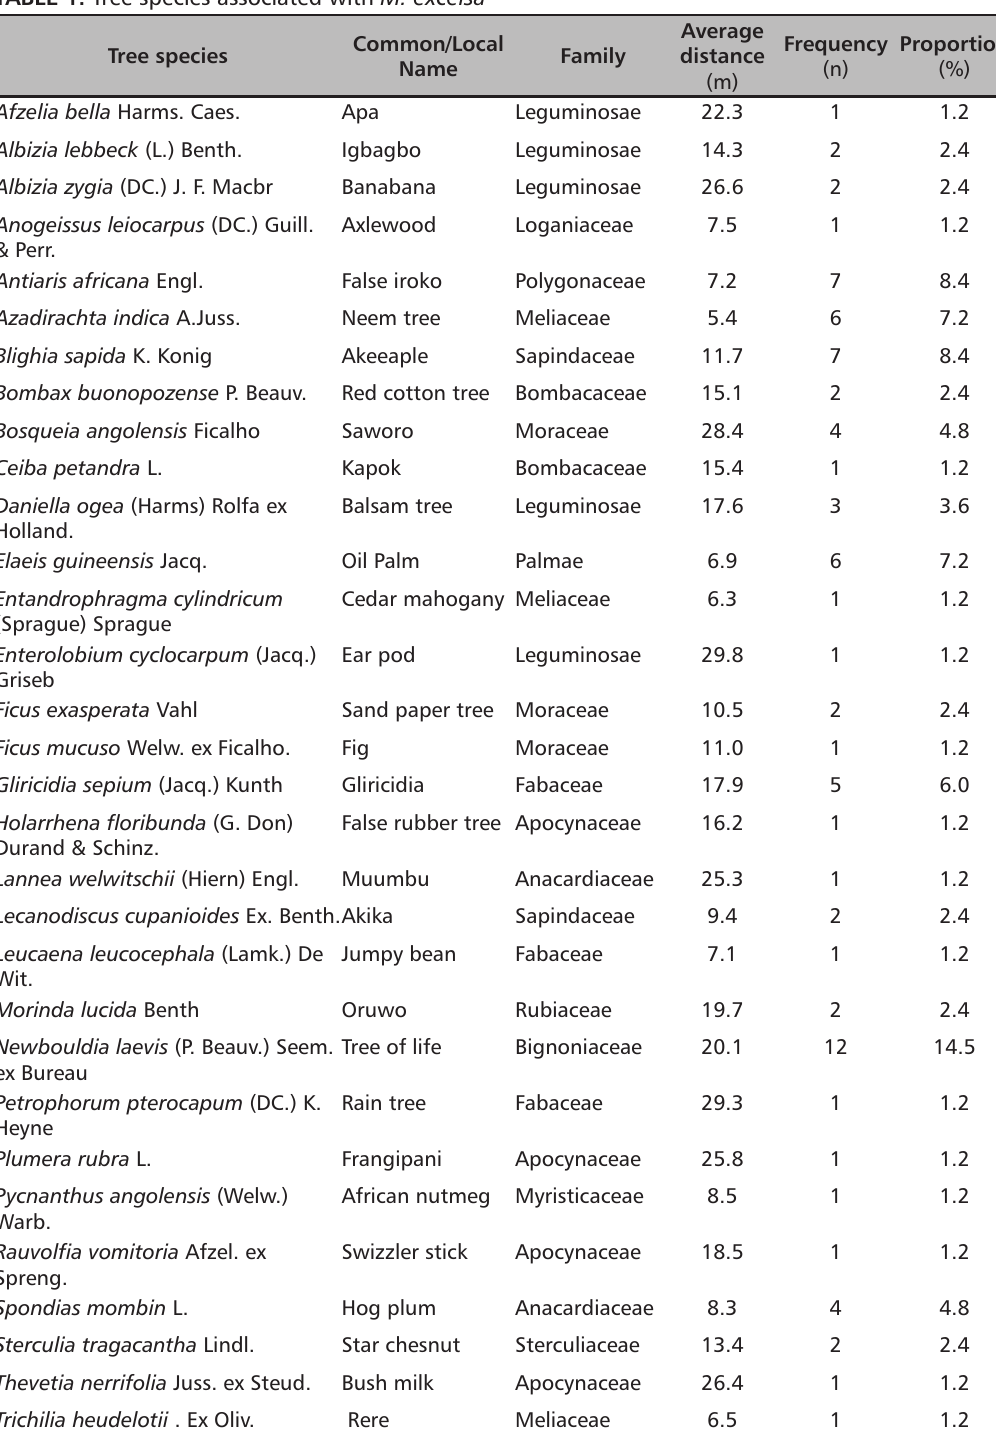
TABLE 1. Tree species associated with M. excelsa Tree